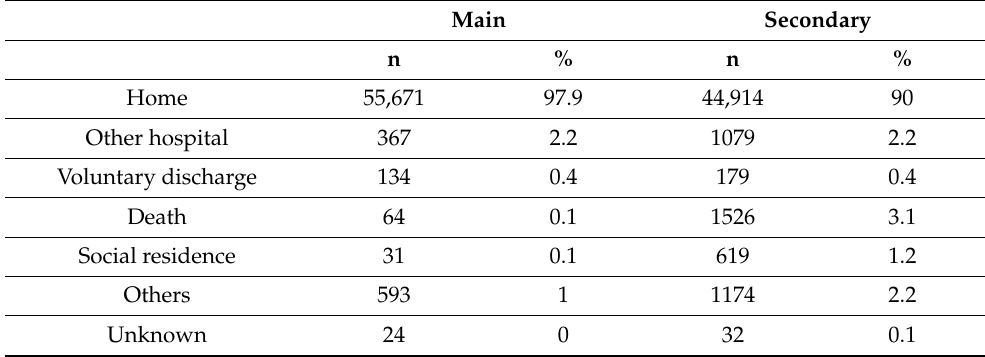
Table 6. Discharge destinations for patients when lithiasis was coded as main diagnosis or a secondary code.